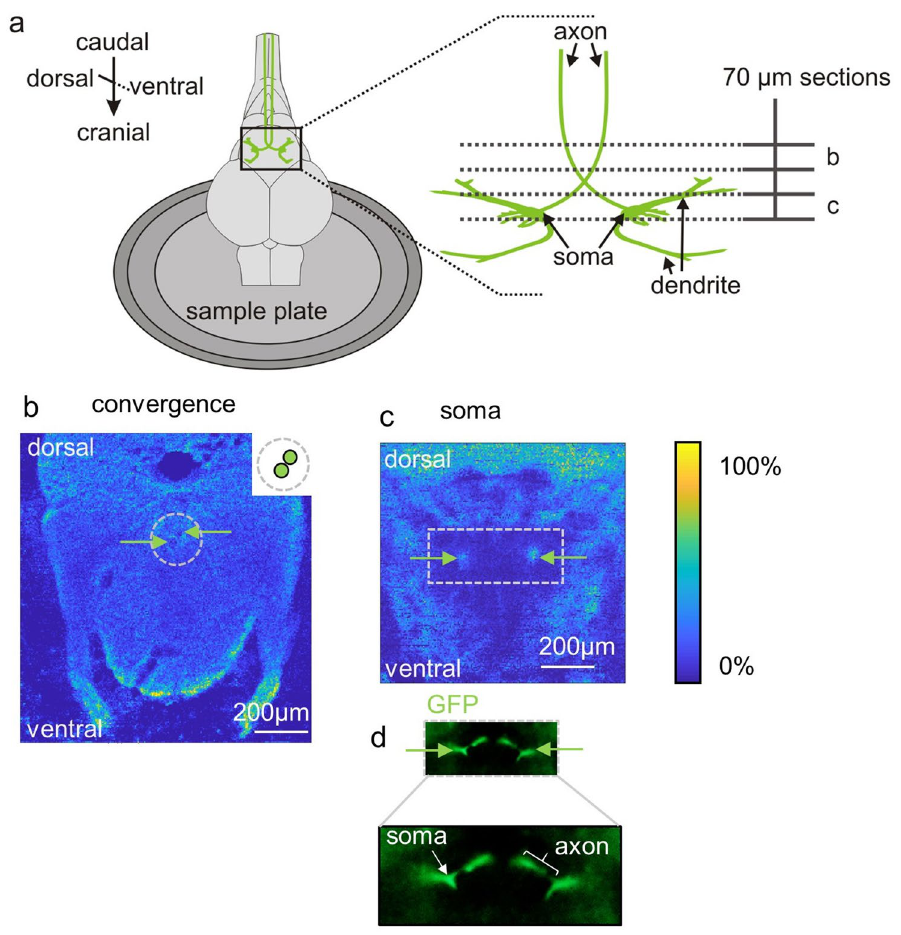
Figure 3. Spatial localization of a central command neuron within tissue sections of zebrafish using MALDI MSI. ( a ) Schematic representation of a zebrafish brain fixated on a sample holder, with the central command neurons (the pair of Mauthner neurons) shown in green. On the right side the two Mauthner neurons are magnified and the position of two sections (70 µm thickness) are illustrated with dotted lines. ( b , c ) Positive ion MS images. ( b ) MS image of PC (36:1) [M+H] + visualizing the axon arrangement before the point where the axons cross the midline. Axons are labeled with green arrows and a schematic illustration of the axon region is shown on the right side of the MS image. ( c ) MS image of the somata of the two neurons (labeled with green arrows), visualized by the distribution of PC (38:6) [M+H] + . ( d ) Fluoresence microscopy of tissue section from transgenic line Tol056 (that expresses GFP in the neuron) was used to conveniently select appropriate sections for subsequent